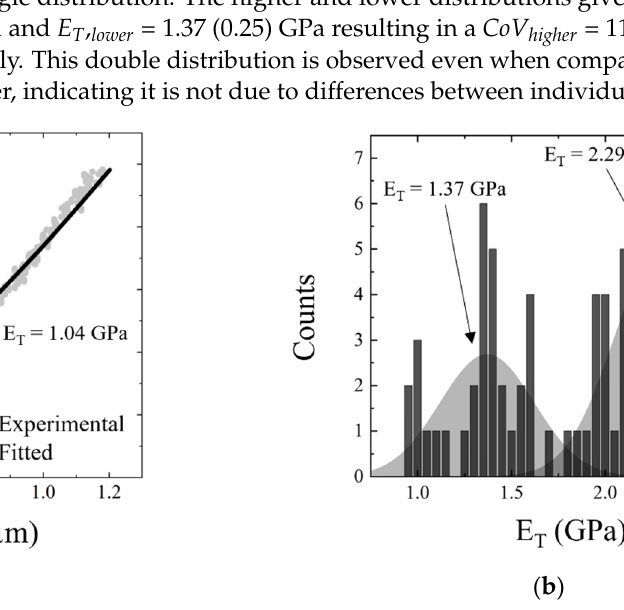
Figure 2. ( a ) Two fitted load–displacement curves from 30C-7× WF, with E T as indicated. These compressions were performed on the same fiber, with compression position less than 2 mm apart. ( b ) A histogram showing the distribution of the fitted E T values. The data is best fit by two normal distributions, centered at 1.37 GPa and 2.29 GPa with a standard deviation of 0.25 GPa and 0.26 GPa, respectively.